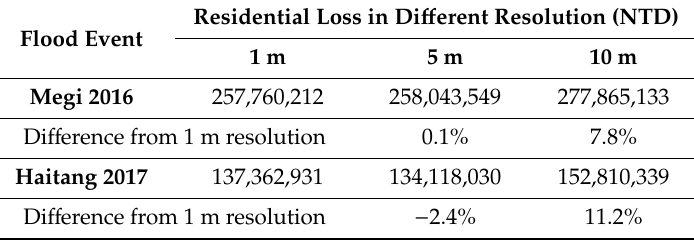
Table 4. Flood loss comparison of l m